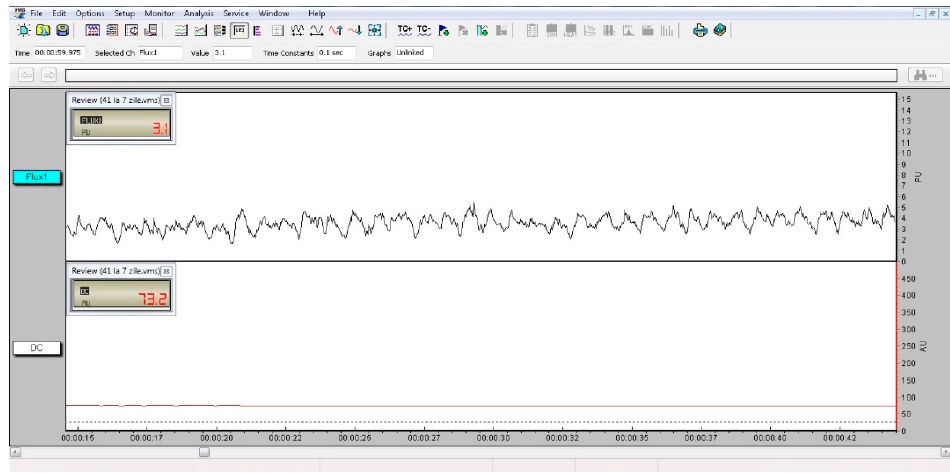
Figure 5. Laser Doppler pulp level signal for tooth 41, seven days after the treatment. The pulsatory signal is shown in the upper